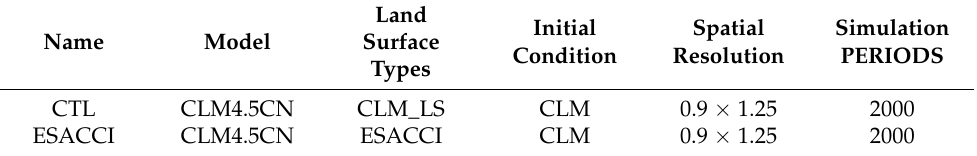
Table 3. Experimental